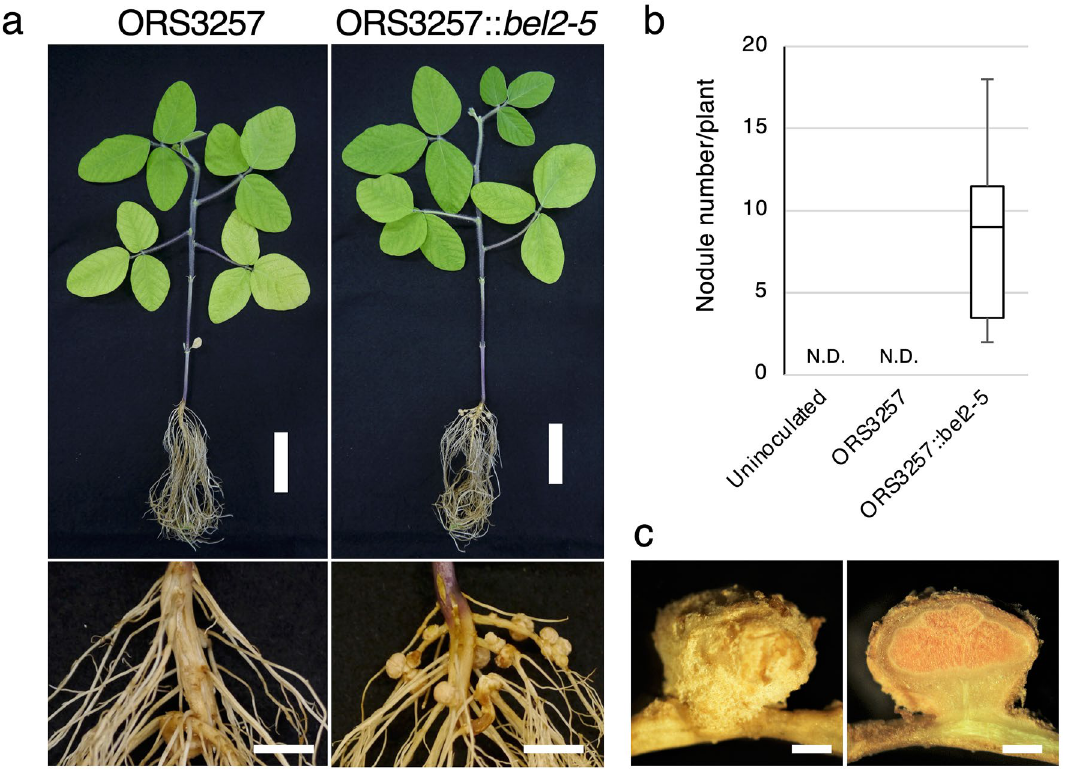
Figure 5. Bel2-5 confers hijacking activity to another rhizobia. ( a ) G. max cv. En1282 ( nfr1 mutant soybean) inoculated with Bradyrhizobium sp . ORS3257 wild-type and with insertion of bel2-5 gene, designed as ORS3257:: bel2-5 . Whole plants (scale bars: 5 cm) and root nodules (scale bars: 1 cm) were photographed at 30 dpi. ( b ) The number of nodules formed on En1282 inoculated with uninoculated (water), ORS3257 and ORS3257:: bel2-5 . Nodules were counted at 30 dai. Values represent mean ± SD ( n = 18, from three independent inoculation tests). N.D.: Not detected. ( c ) nodules section of En1282 inoculated with ORS3257:: bel2-5. Scale bars: 1